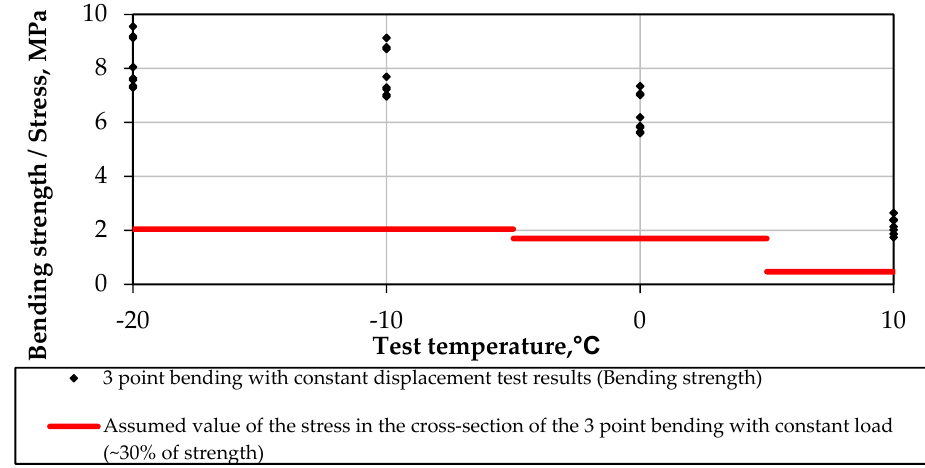
Figure 5. Stress levels at various test temperatures applied in the Bending Beam Creep Test (BBCT).